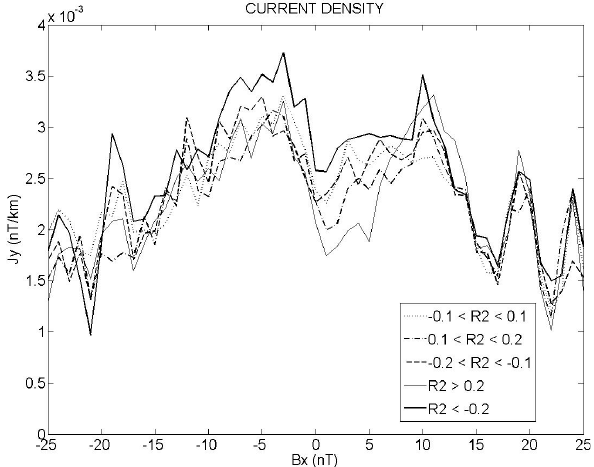
Fig. 9. The electric current density distributions j y (B x ) for differ- ent temperature anisotropy ratios R 3